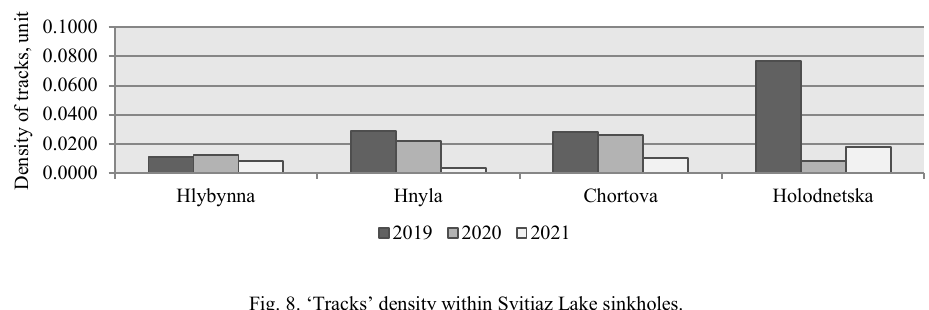
Fig. 8. ‘Tracks’ density within Svitiaz Lake sinkholes.